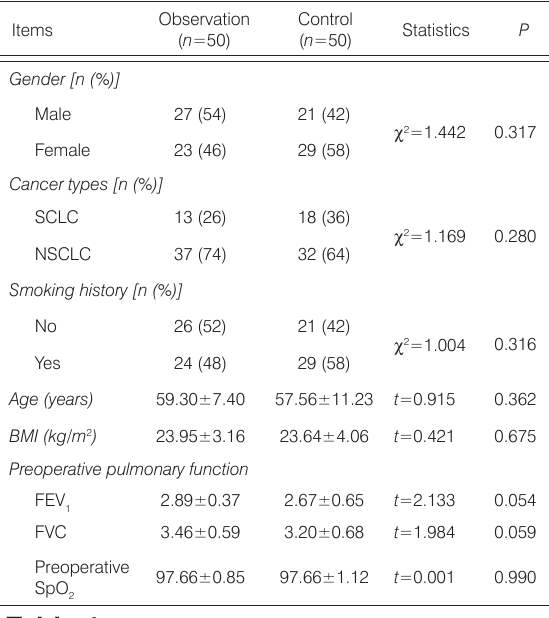
Table 1. General data of the two groups. Notes: SCLC, small cell lung cancer; NSCLC, non-small cell lung cancer; BMI, body